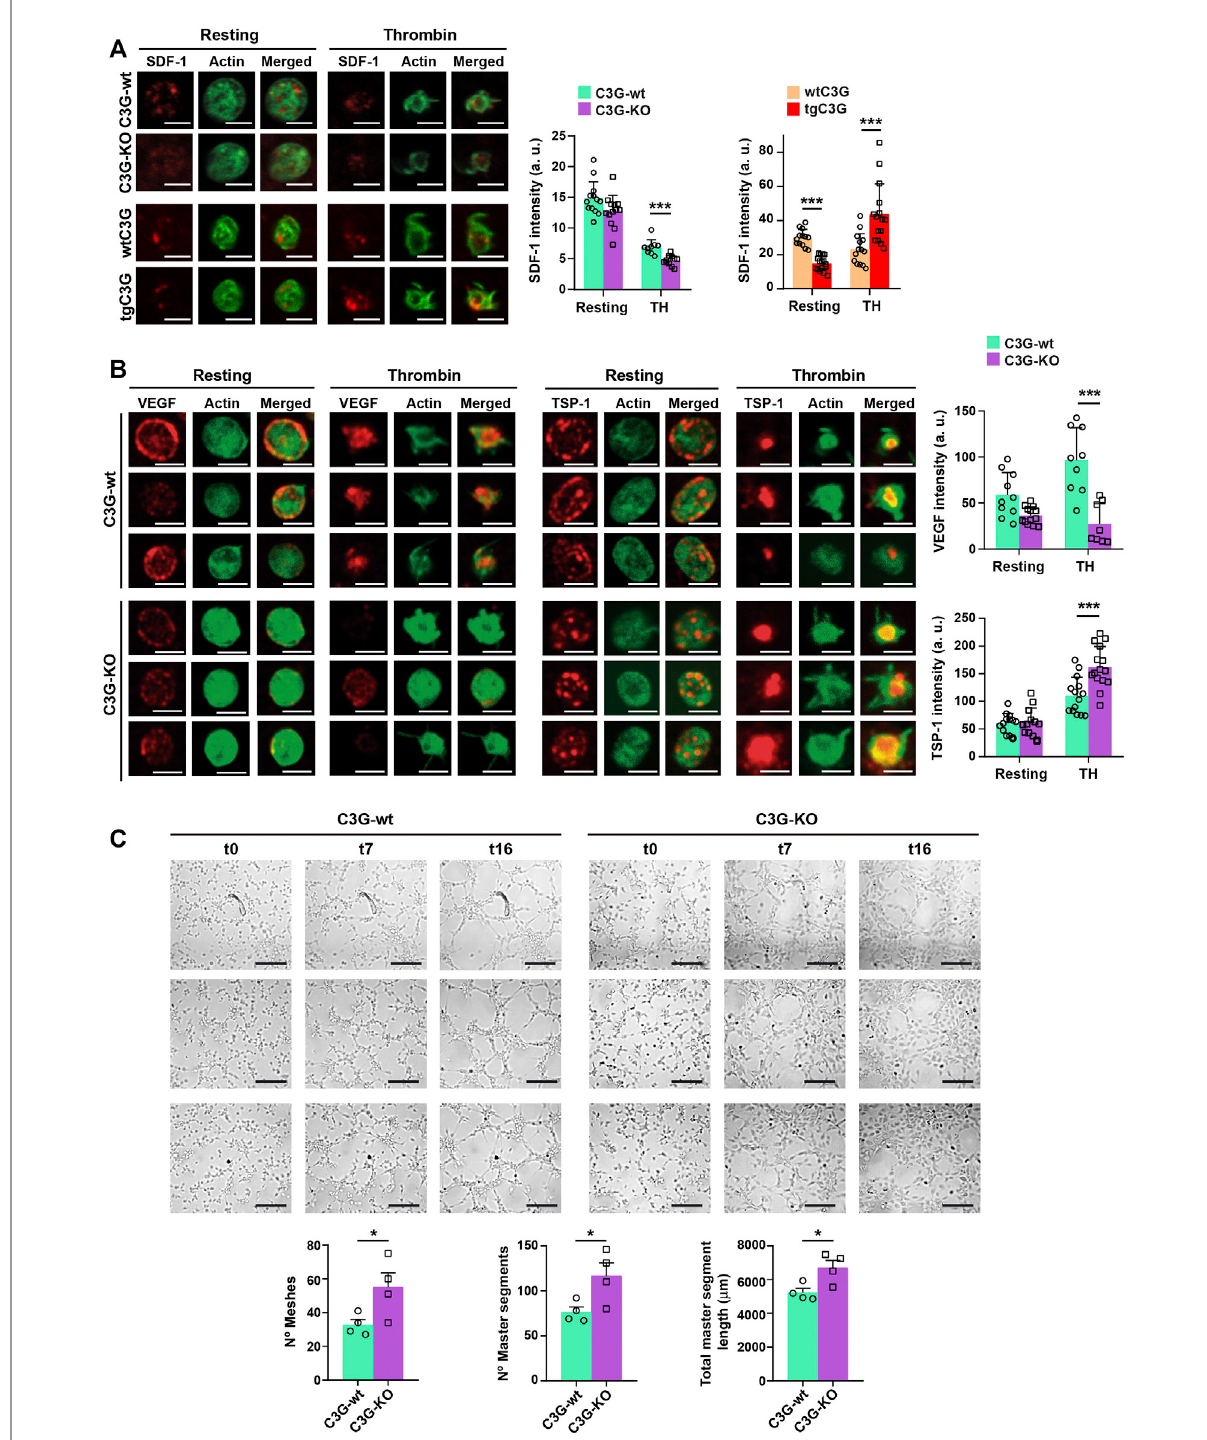
FIGURE 2 C3G deletion enhances SDF-1 and VEGF release, while C3G overexpression retains SDF-1. (A) Representative immuno fl uorescence images of tgC3G, C3G-KO and control platelets, untreated or treated with thrombin (TH, 0.5 U/ml, 5 min) and stained with anti-SDF-1 + Alexa Fluor ™ -647 (red)andphalloidin-488(green),takenatthesameexposuretime.Bar:2.5 µm.Histogramsrepresentthemean±SDofSDF-1 fl uorescenceintensity. (B) Representative immuno fl uorescence images ofC3G-KOand control platelets untreated or treatedwith thrombin(TH, 0.5 U/ml, 5 min)and stained with anti-TSP-1 + Alexa Fluor ™ -647 (red) or anti-VEGF + Alexa Fluor ™ -647 (red) and phalloidin-488 (green). All images were taken at the